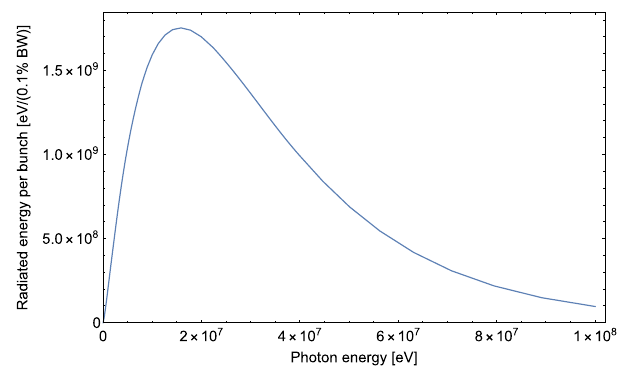
FIG. 13. Betatron radiation emitted by a single electron bunch (charge ¼ 0 . 32 pC, σ x ¼ 13 nm, σ z ¼ 110 nm) as it propagates a distance of 1.6 mm with n i ¼ n 0 ; ion collapse effects are not